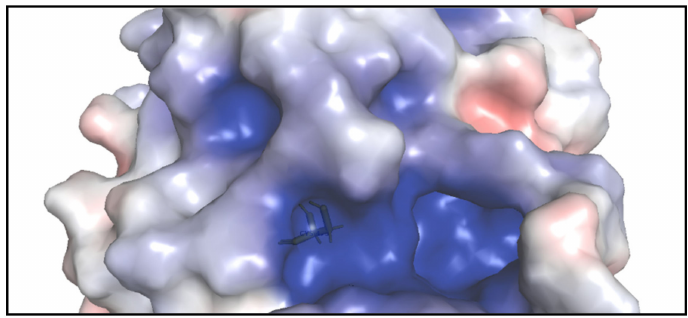
Figure 2. The surface of Cdc25B shows the shallow active site (where the stick of Cys473 is shown) and the adjacent inhibitory pocket which is deeper and